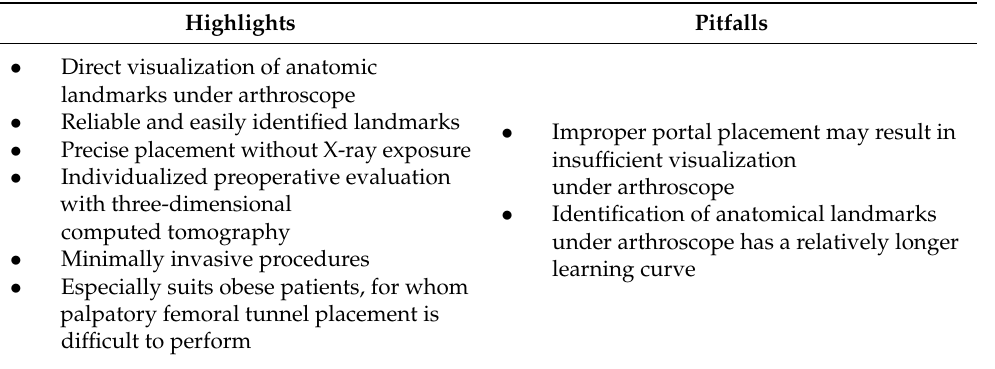
Table 1. Highlights and pitfalls of discussed